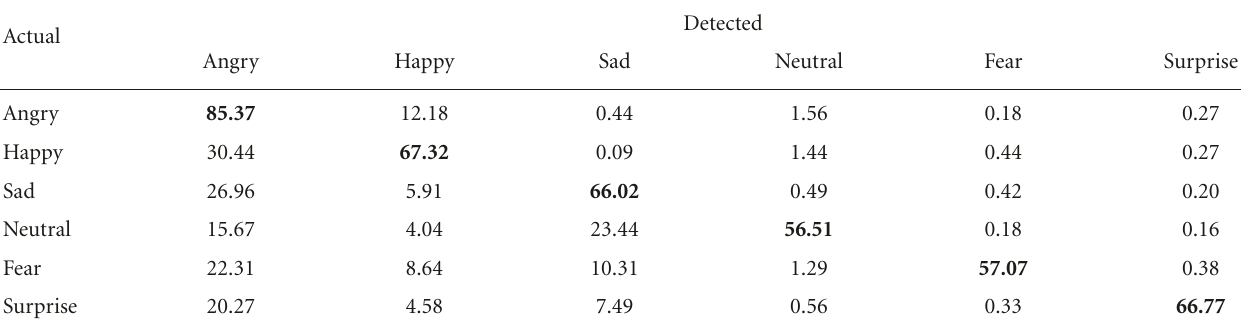
Table 3: Six emotions recognition rate (%) for a balanced speaker and text independent test-utterance based: 100 utterances per emotion, random sequence of speakers.